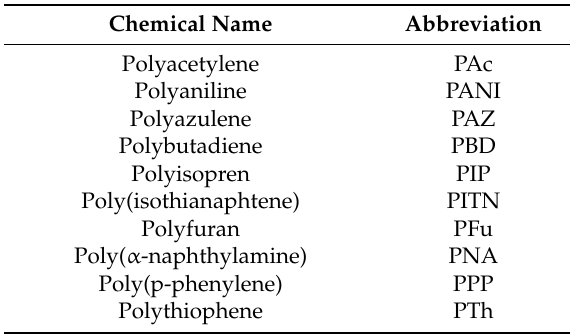
Table 1. Some electro-conductive polymers and their